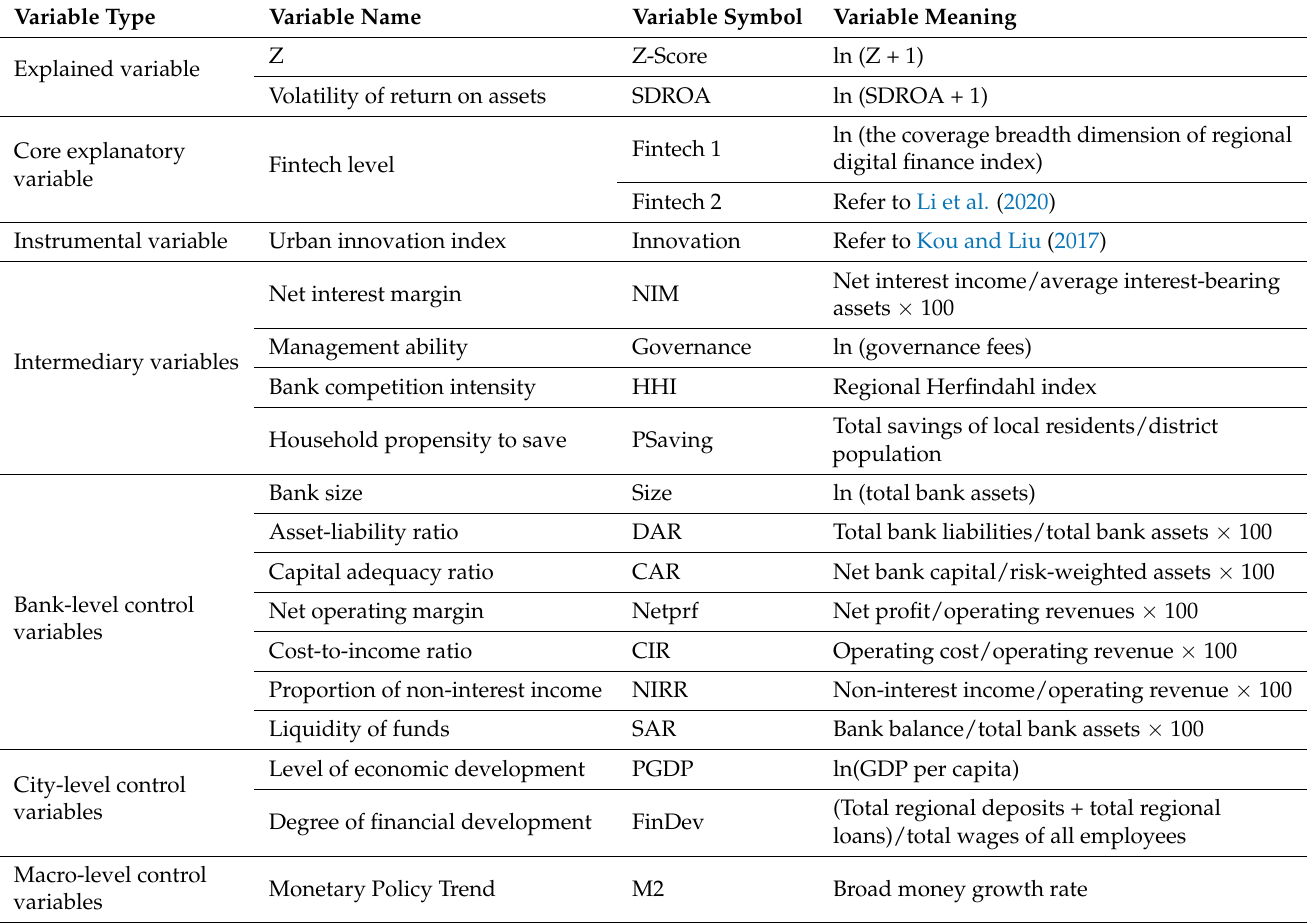
Table 1. Variable selection and